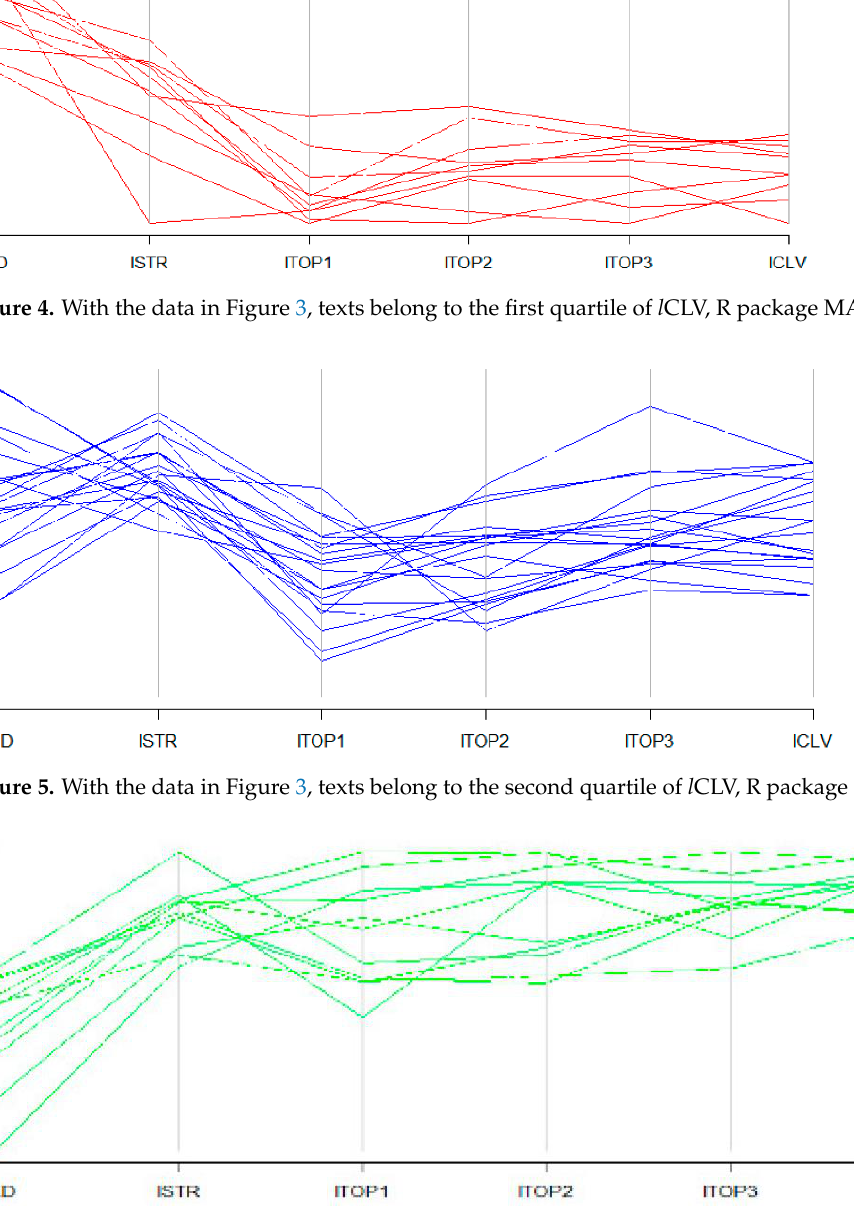
Figure 6. With the data used in Figure 3, texts belong to the third quartile of l CLV, R package MASS.